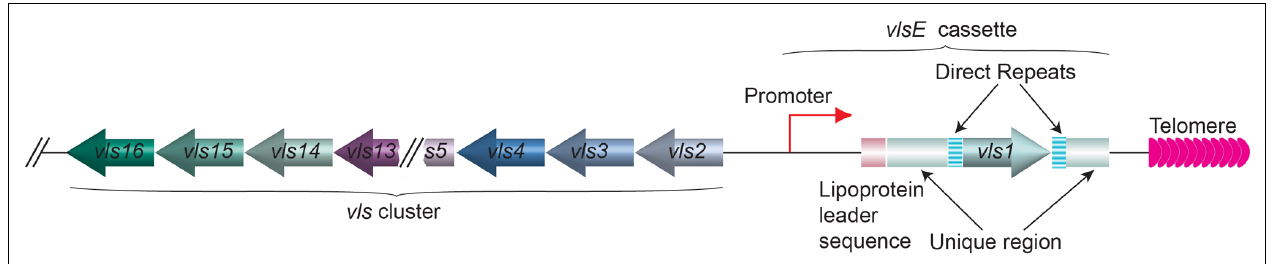
flanking the vls1 gene and the lipoprotein leader sequence (rouge box) upstream of vls1 are marked.The silent array includes vls2–16 genes (various colored arrows) going to the opposite direction from vls1 are located at the internal region of the linear